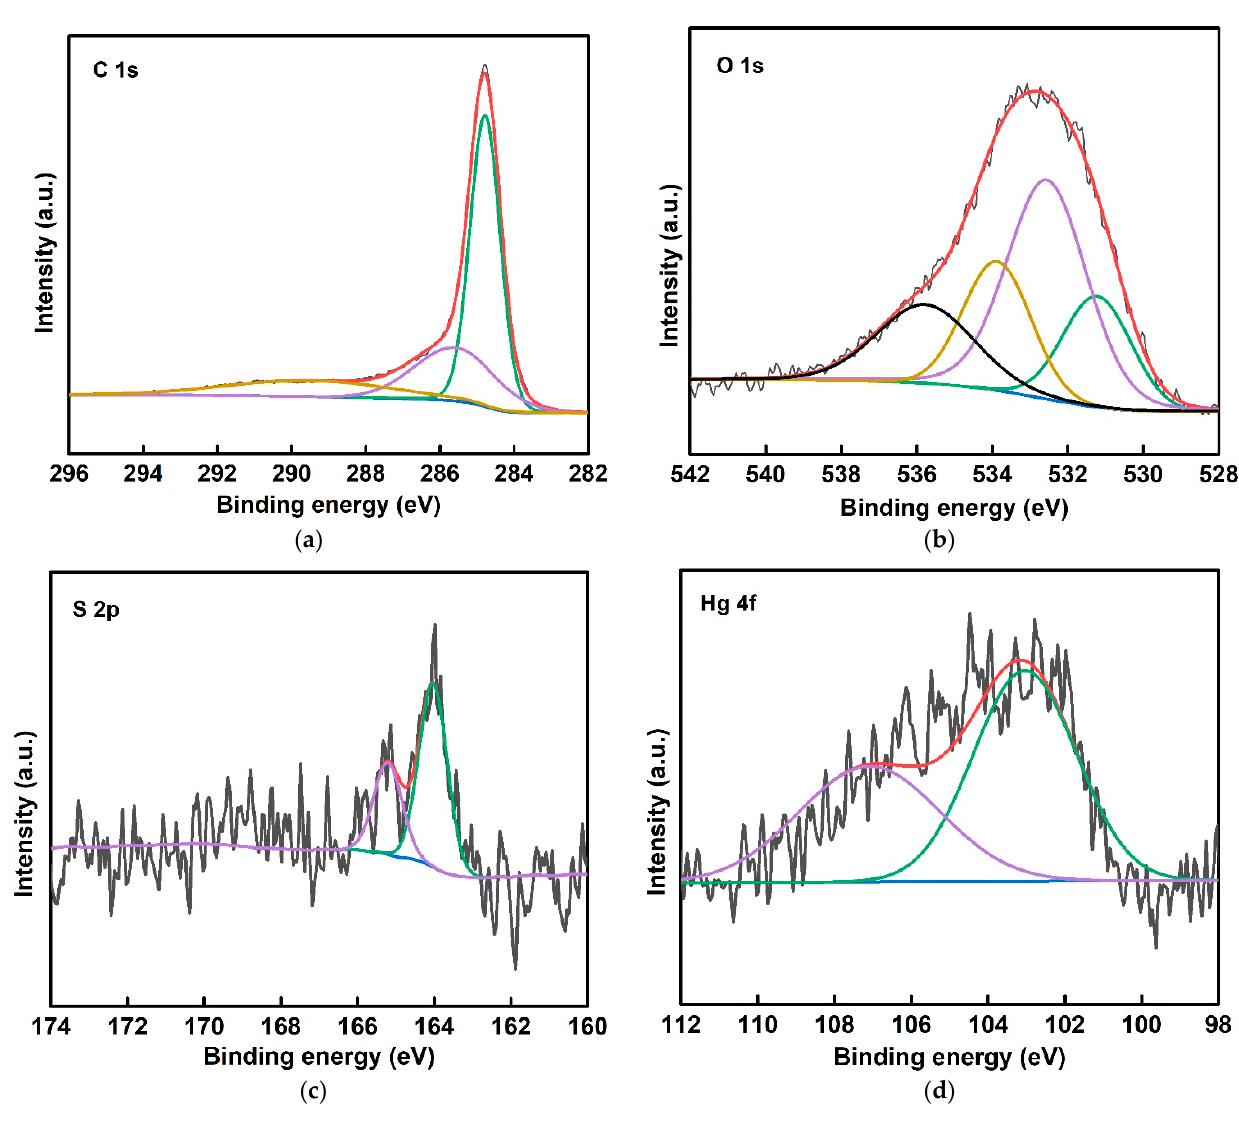
Figure 11. ( a ) C 1s, ( b ) O 1s, ( c ) S 2p, and ( d ) Hg 4f spectra of spent